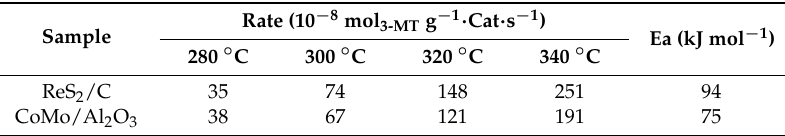
Table 1. Reaction rates and apparent activation energies (Ea) for the catalysts evaluated in a flow reactor and calculated under kinetic control in steady-state conditions (conversions between 15% and 20%) and atmospheric pressure conditions at 280, 300, 320 and 340 ◦ C.